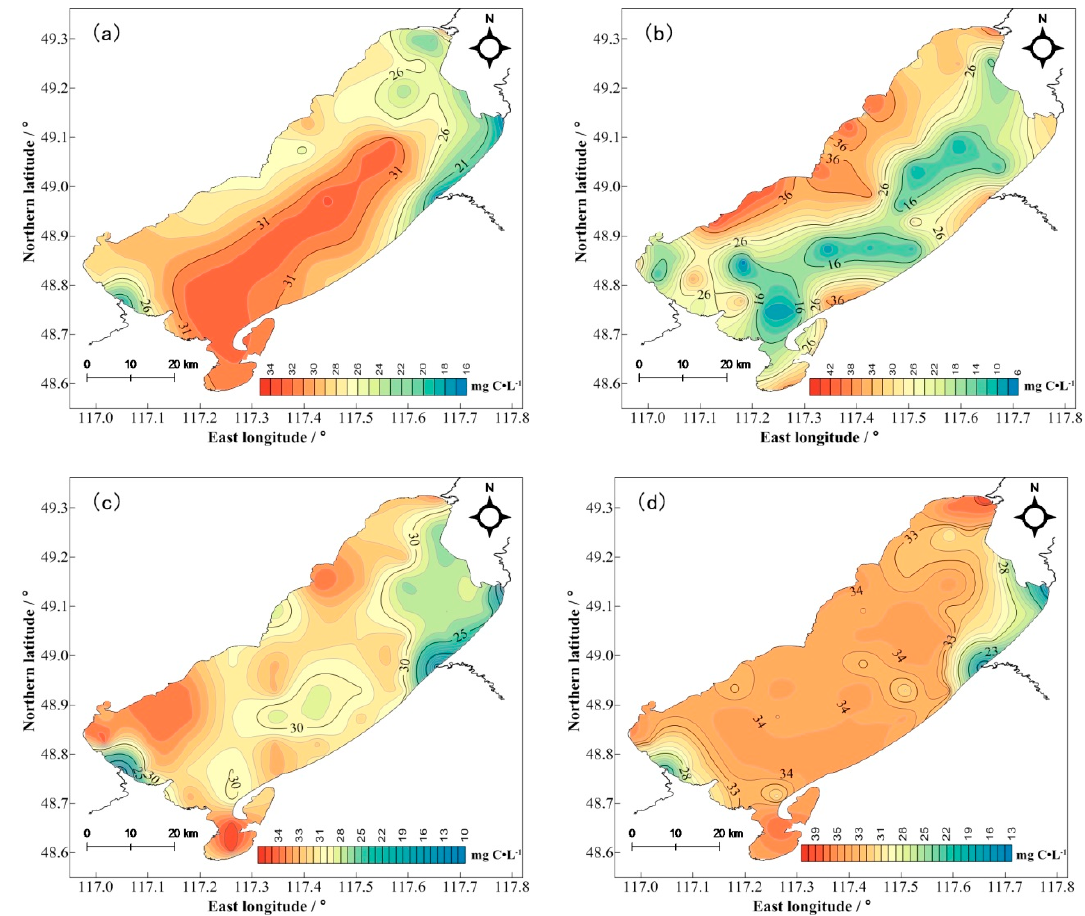
Figure 2. Spatial distributions of dissolved organic matter (DOM) concentrations (dissolved organic carbon (DOC), mg C·L − 1 ) in ( a ) autumn: October 2018, ( b ) winter: March 2019, ( c ) spring: May 2019 and ( d ) summer: July 2019.